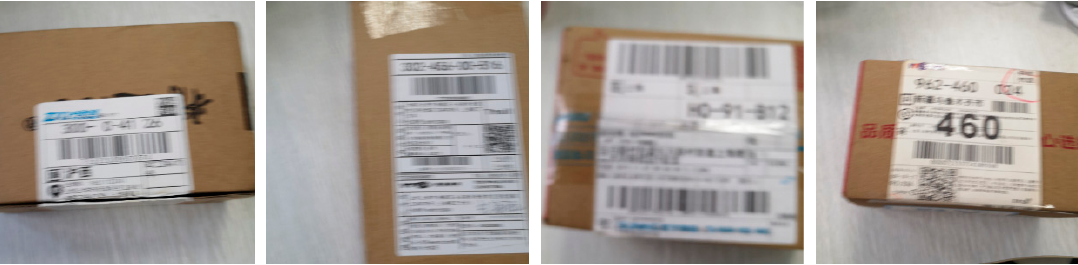
Figure 7. Partial unpaired dataset.